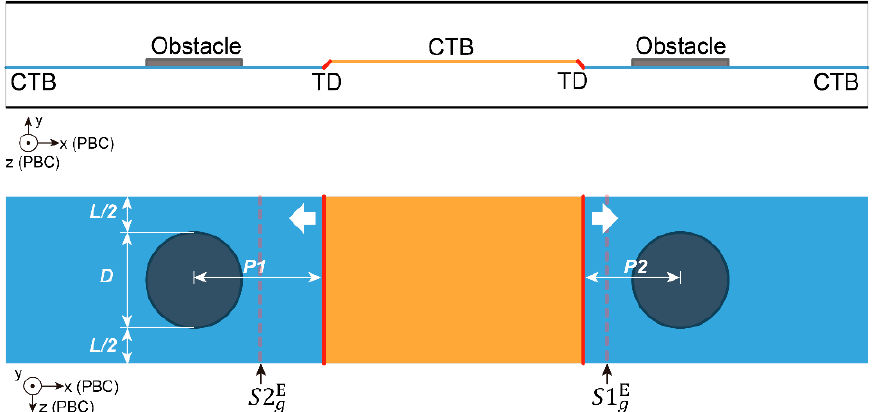
Figure 1. The schematic diagram of the simulation system containing a CTB and a TD dipole. The two black cylinders are the impenetrable obstacles used for Orowan stress measurement.